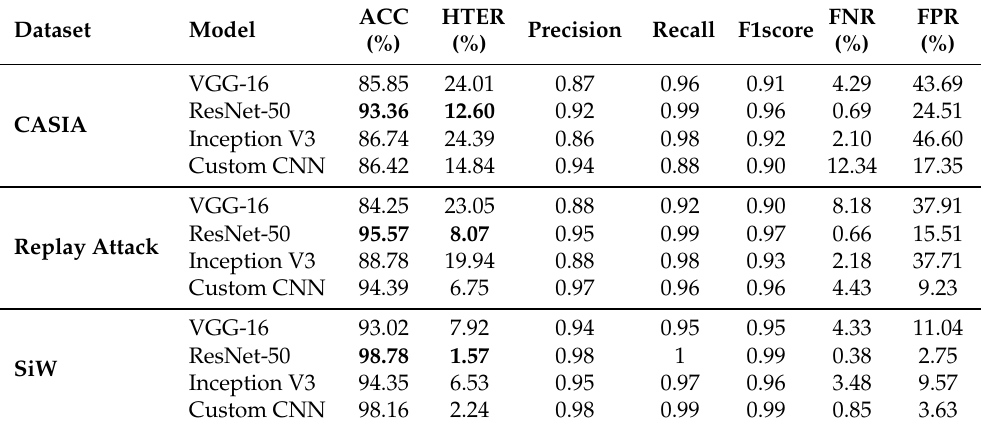
Table 3. FPAD results using deep CNN models.